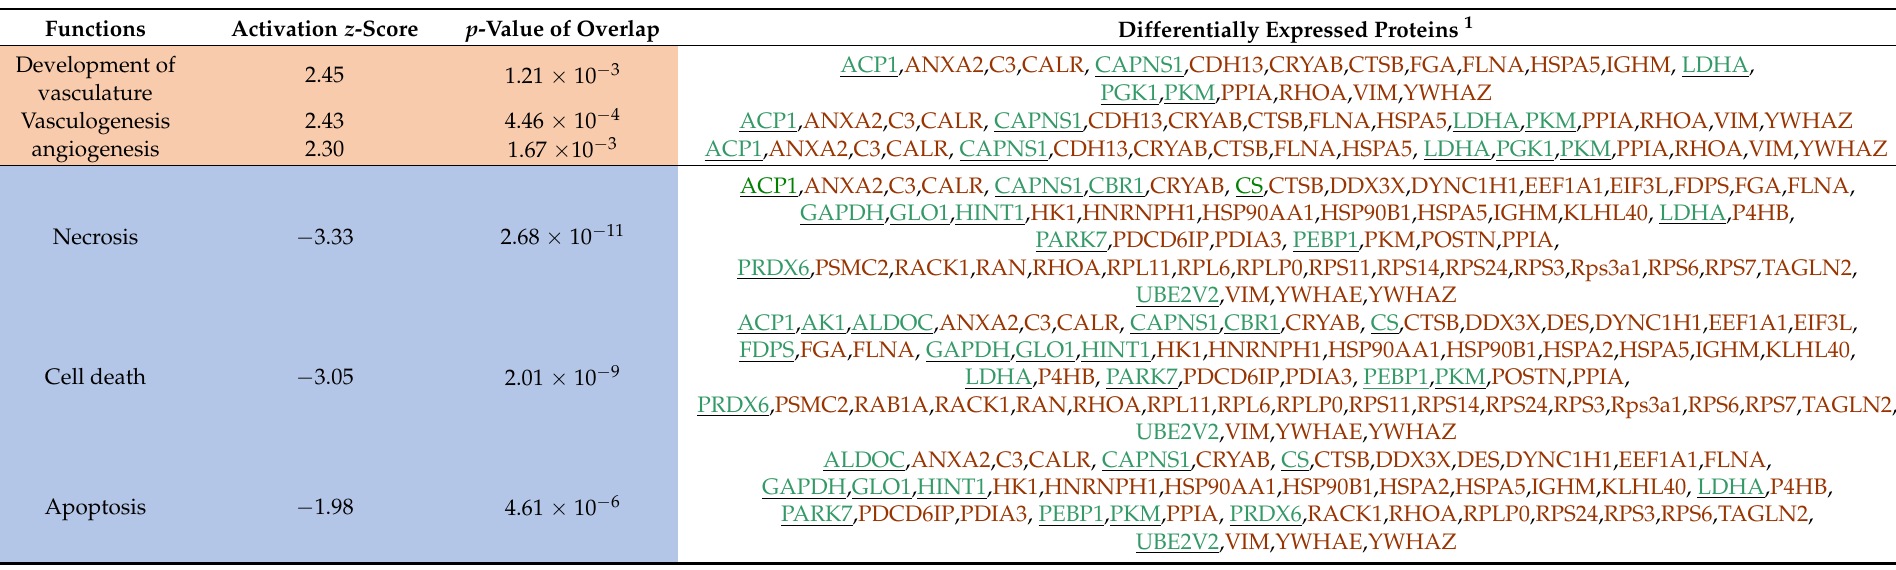
Table 2. Functions predicted to be activated (orange) or inhibited (blue) in wooden breast (WB) myopathy compared to normal muscle based on differentially expressed (DE) target molecules in commercial